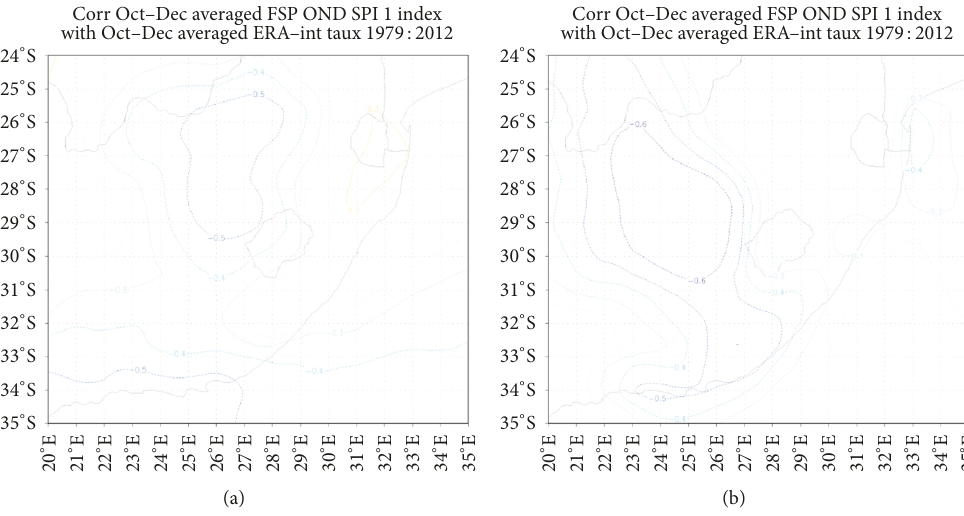
Figure 8: Spatial correlation of Free State OND SPI with (a) zonal surface winds and (b) meridional surface winds during OND for the period from 1960 to 2013. Tau- 𝑥 and tau- 𝑦 mean surface winds in the zonal and meridional direction,